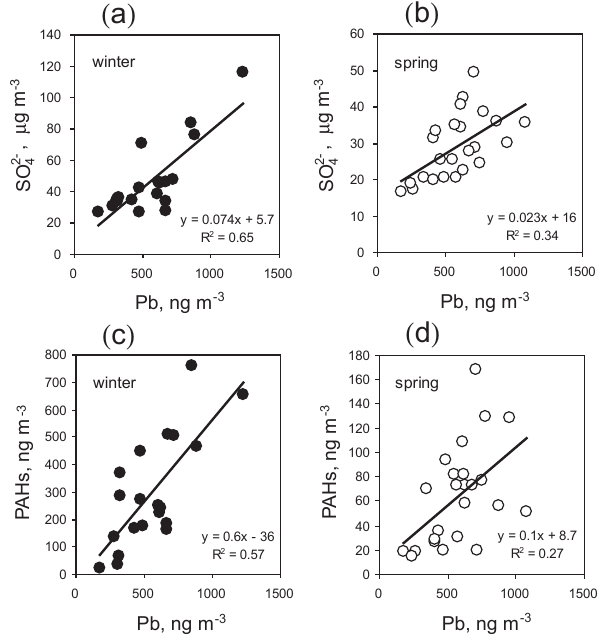
Fig. 7. Correlation of Pb with sulfate and PAHs in the PM 10 of Baoji city during winter and spring (Sulfate data are cited from Wang et al. (2009a), and PAH data are cited from Xie et al. (2009)).